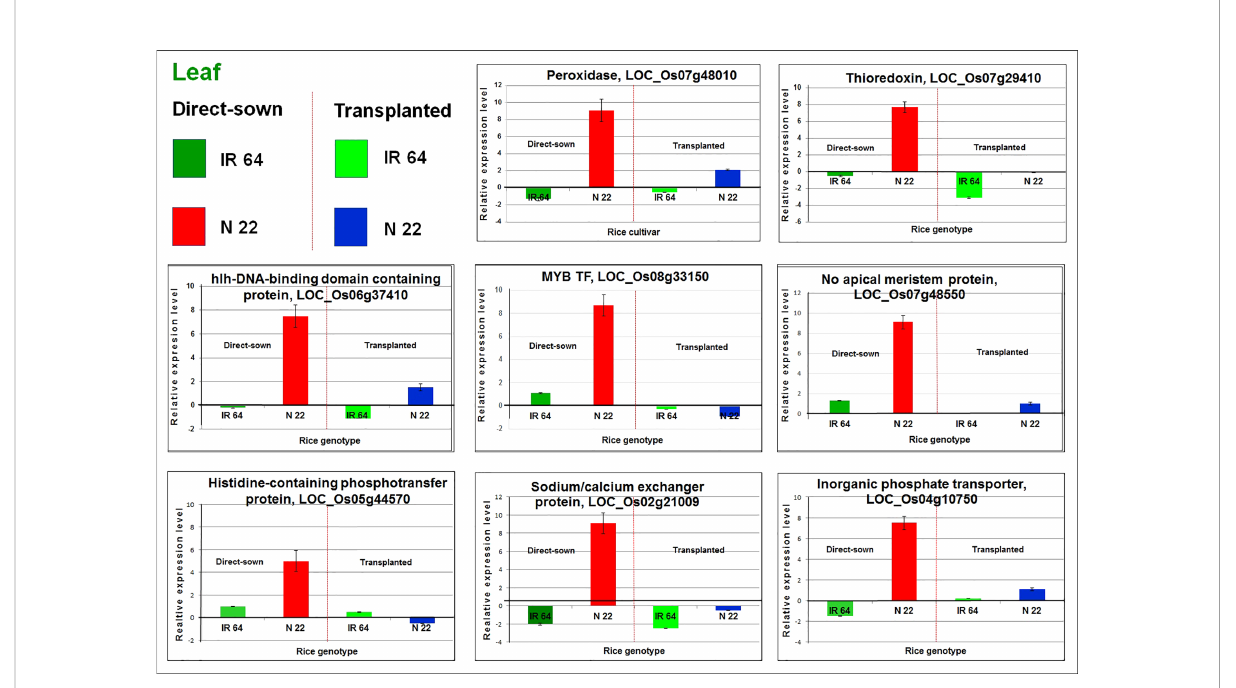
FIGURE 9 RT-qPCR validation of eight randomly selected differentially expressed genes in leaf of Nagina 22 (N 22). The cDNA was prepared from total RNA isolated from leaf of N 22 and IR 64 grown by transplanting and direct-sowing subjected to drought stress at the reproductive stage. Data represent the mean ± SD (n =